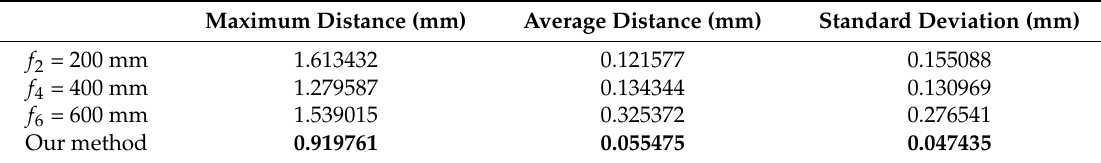
Table 1. Comparison of surface smoothness of reconstructed